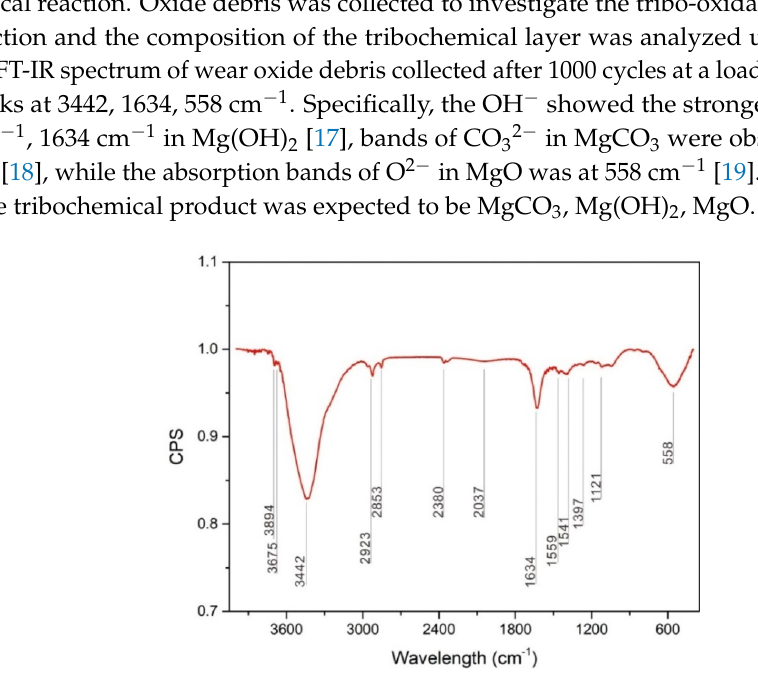
Figure 7. Max stresses at different depth for 100 cycles at different loads. ( a ) 0.1 N, ( b ) 1 N, and ( c ) 10 N.